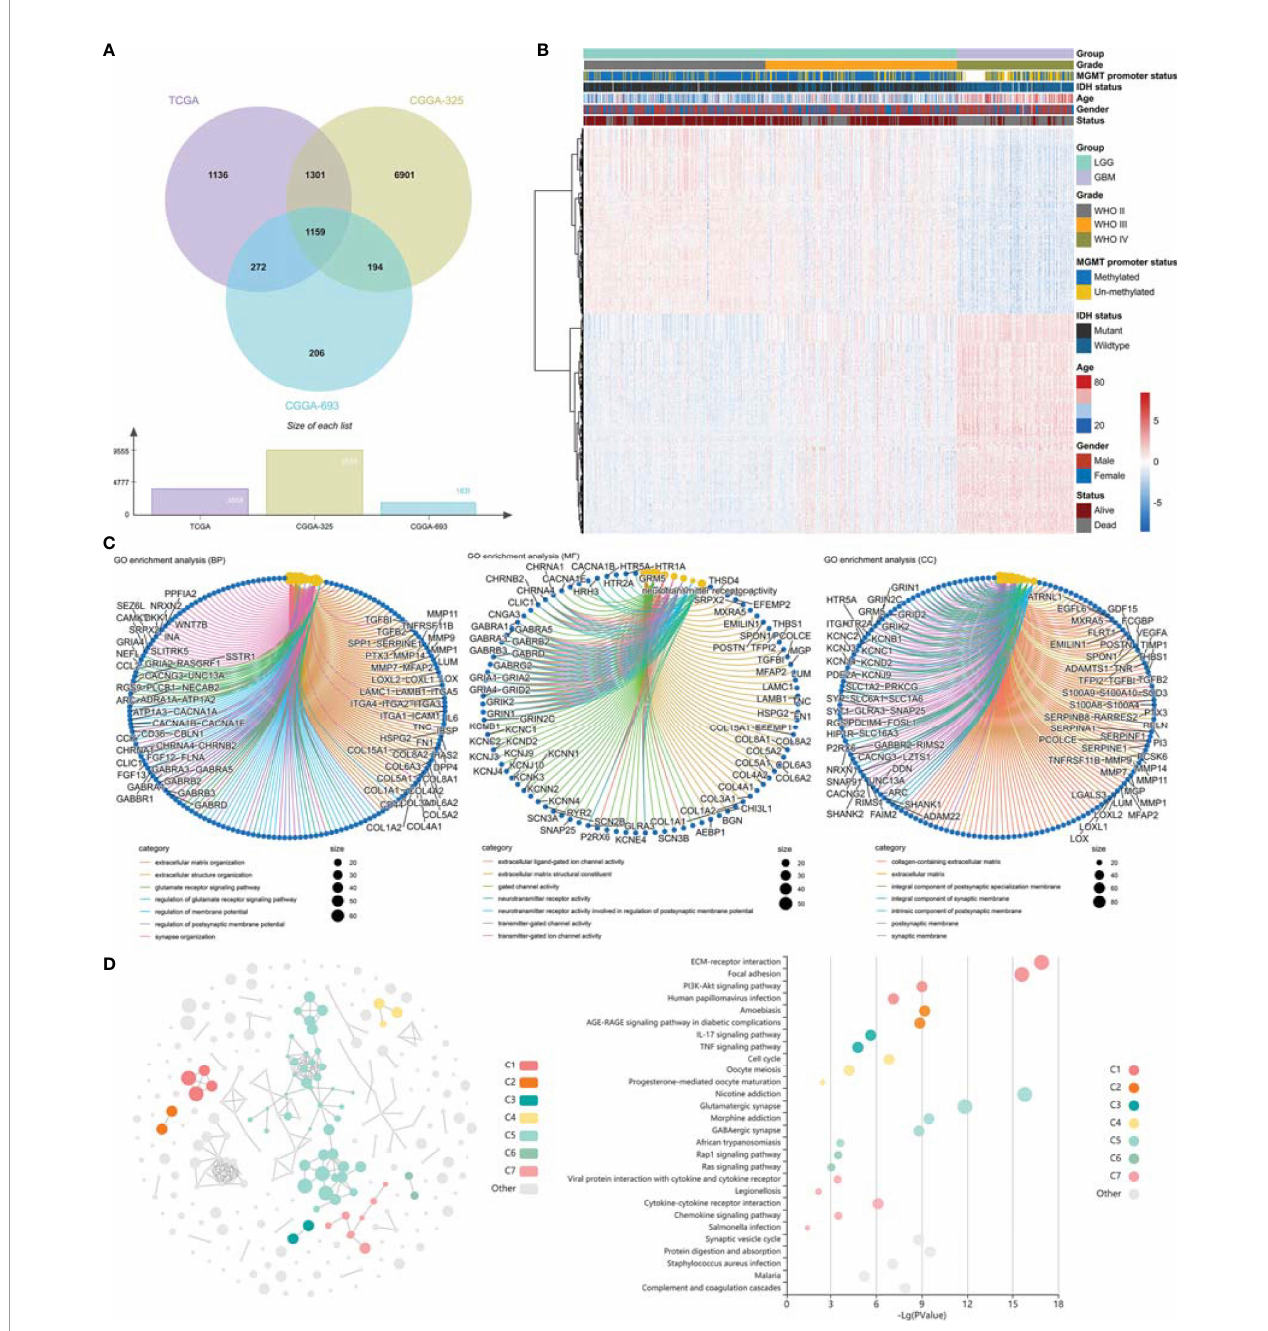
FIGURE 3 | Identi fi cation of differentially expressed genes and gene enrichment analysis. (A) Venn diagram showed the differentially expressed genes in TCGA GBMLGG cohort, CGGA #325 cohort, and CGGA #693 cohort, respectively. (B) Heatmap displayed the expression pro fi le of the 1,159 DEGs. (C) GO analysis of the differentially expressed genes. (D) KEGG analysis of the differentially expressed genes. GO, Gene Ontology; KEGG, Kyoto Encyclopedia of Genes and